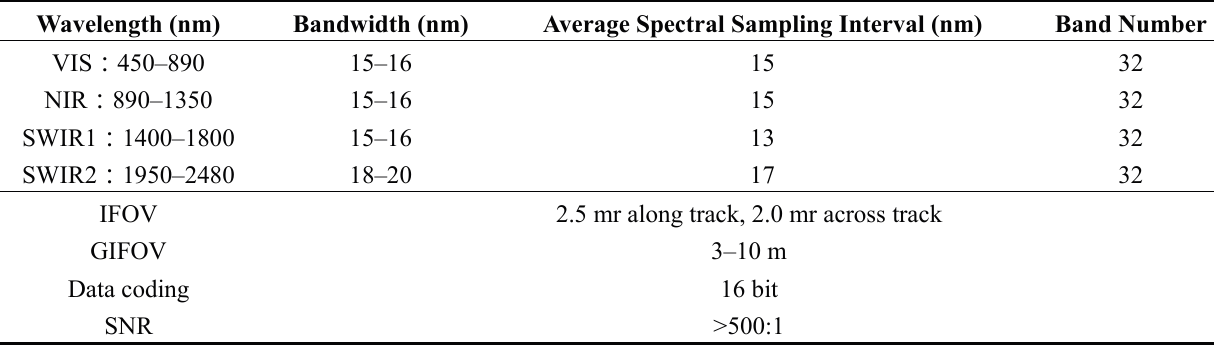
Table 1. Relevant technical parameters of the HyMap spectrometer